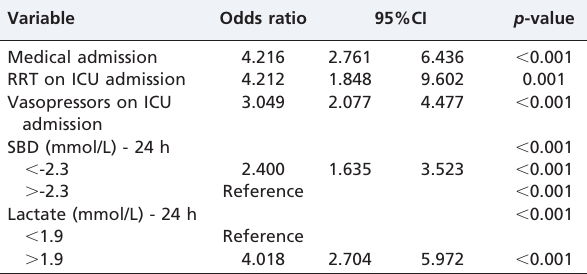
Table 2 - Multiple logistic regression to determine predictive factors for ICU